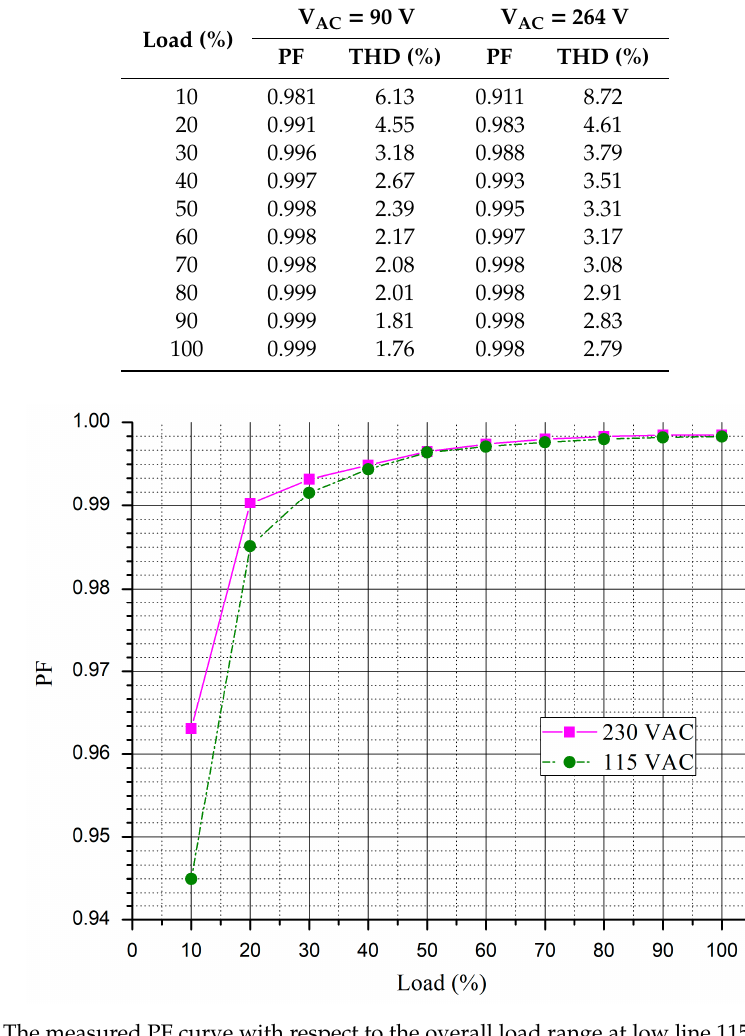
Figure 14. The measured PF curve with respect to the overall load range at low line 115 VAC and high line 230 VAC.